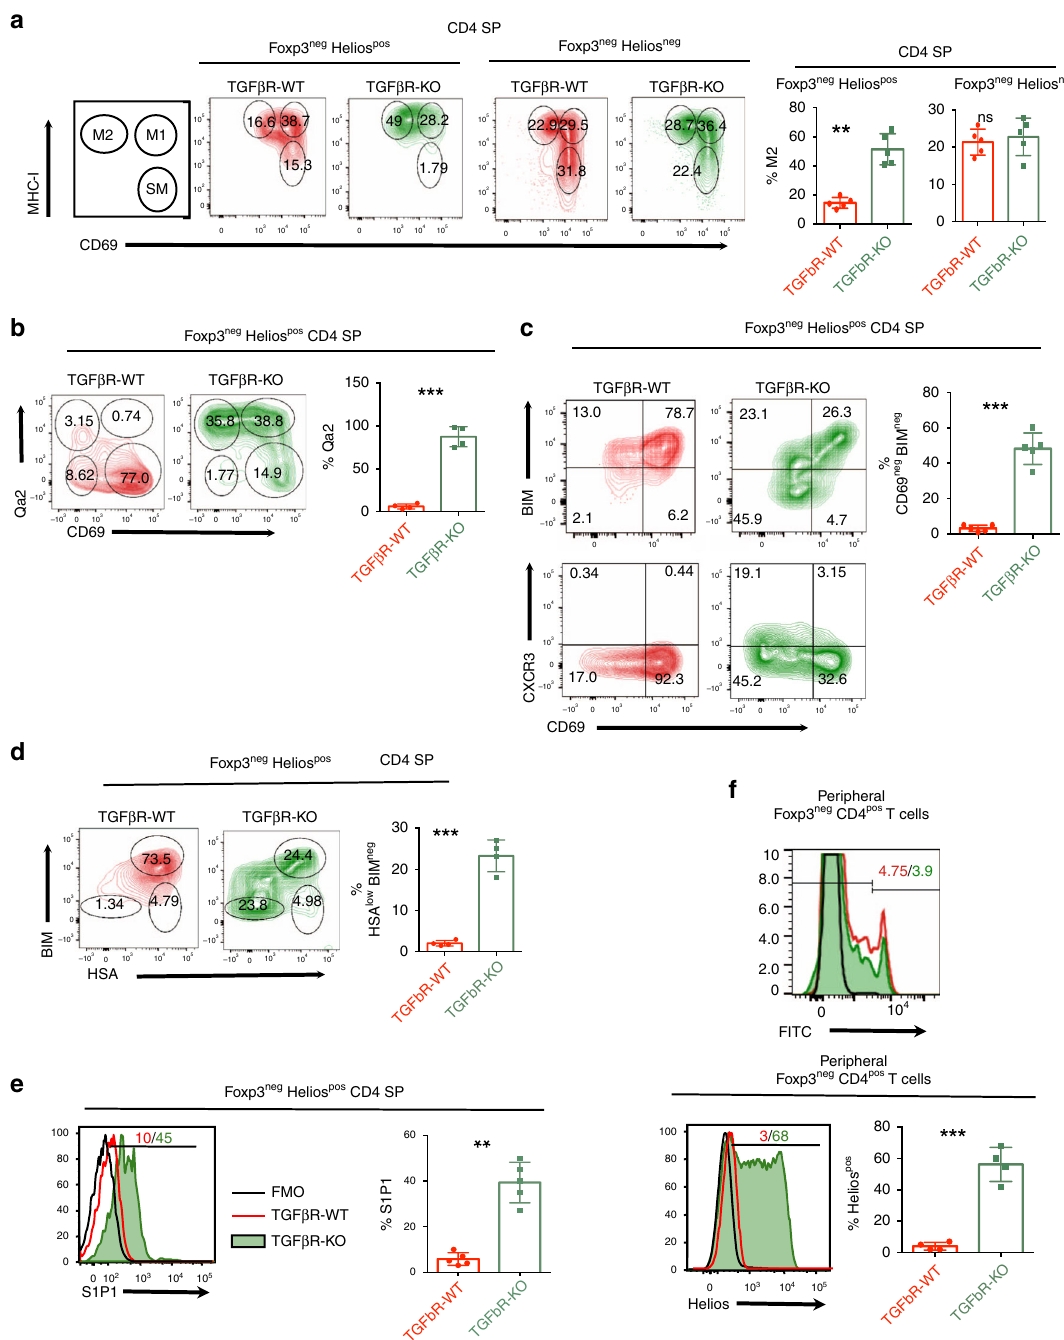
Fig. 5 TGF- β prevents exacerbated maturation and thymic egress of Helios pos thymocytes. a – e Flow cytometry analysis based on gating strategy depicted in Fig. 1a, b. a Flow cytometry contour plots illustrating the SM-M1-M2 populations among Foxp3 neg Helios pos CD4 SP thymocytes and Foxp3 neg Helios neg CD4 SP from TGF- β R-KO mice and TGF- β R-WT mice. Histograms demonstrate percentage of M2 cells. b Flow cytometry analysis of Qa-2 and CD69 expression at the surface of Foxp3 neg Helios pos CD4 SP thymocytes from TGF- β R-KO mice and TGF- β R-WT mice. b Histogram illustrates percentage of Qa2 pos cells. c Flow cytometry contour plots demonstrating the expression of BIM, CD69 and CXCR3 in Foxp3 neg Helios pos CD4 SP thymocytes from TGF- β R-KO mice and TGF- β R-WT mice. Histogram illustrates the percentage of CD69 neg BIM pos cells among Foxp3 neg Helios pos CD4 SP thymocytes. d Flow cytometry analysis of HSA (CD24) and BIM expression on Foxp3 neg Helios pos CD4 SP thymocytes from TGF- β R-KO mice and TGF- β R- WT mice; the histogram demonstrates the percentage of HSA low BIM neg among the Foxp3 neg Helios pos CD4 SP thymocytes. e Flow cytometry analysis for surface expression of S1P1 on Foxp3 neg Helios pos CD4 SP thymocytes, histogram illustrates the S1P1 MFI in Foxp3 neg Helios pos CD4 SP thymocytes. f CD4- Cre;Tgfbr2 fl / fl mice were injected intra-thymically with FITC and their peripheral lymph nodes were analyzed 24 h later by fl ow cytometry. Histogram plot illustrates the proportion of FITC pos CD4 pos T lymphocytes (top) and was used as gating strategy for the expression of Helios among Foxp3 neg , CD4 pos FITC pos T lymphocytes. The graph demonstrates percentage of Helios pos among CD4 pos FITC pos T lymphocytes. All the experiments were conducted in 7 – 10-day-old animals. Data are representative of 2 – 3 experiments, with 3 – 5 mice per group. * P < 0.05, ** P < 0.01, *** P < 0.001 (two-tailed Student ’ s t test). Error bar, mean ± SEM. Source data are provided as a Source Data fi